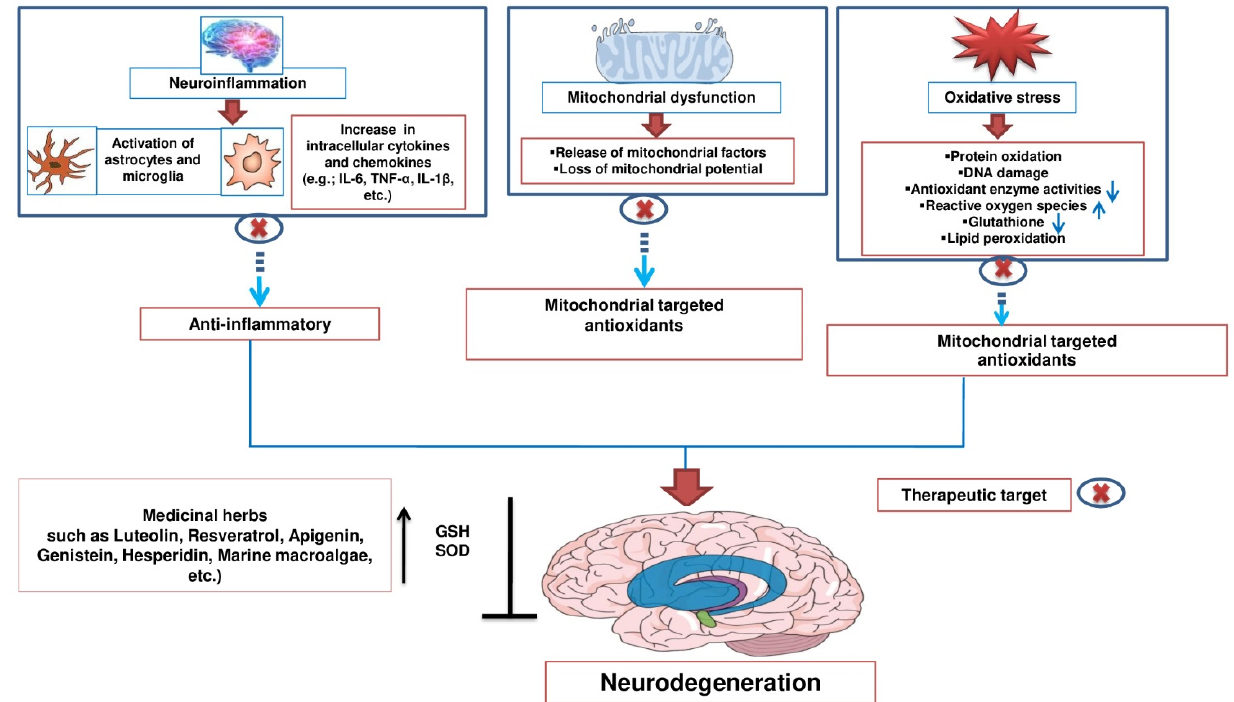
Figure 2. Therapeutic effects of numerous natural products for combating NDs.